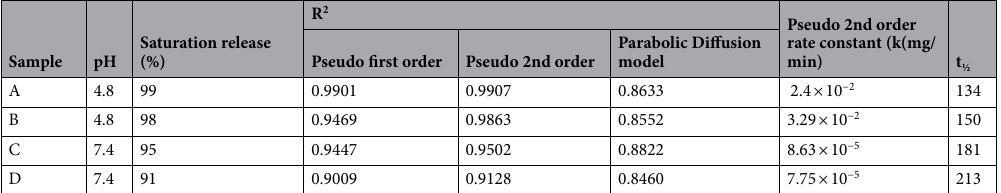
Table 4. The correlation coefficient, rate constant and half-life obtained by fitting the sorafenib release data into the PBS solution at pH 4.8 and pH 7.4.